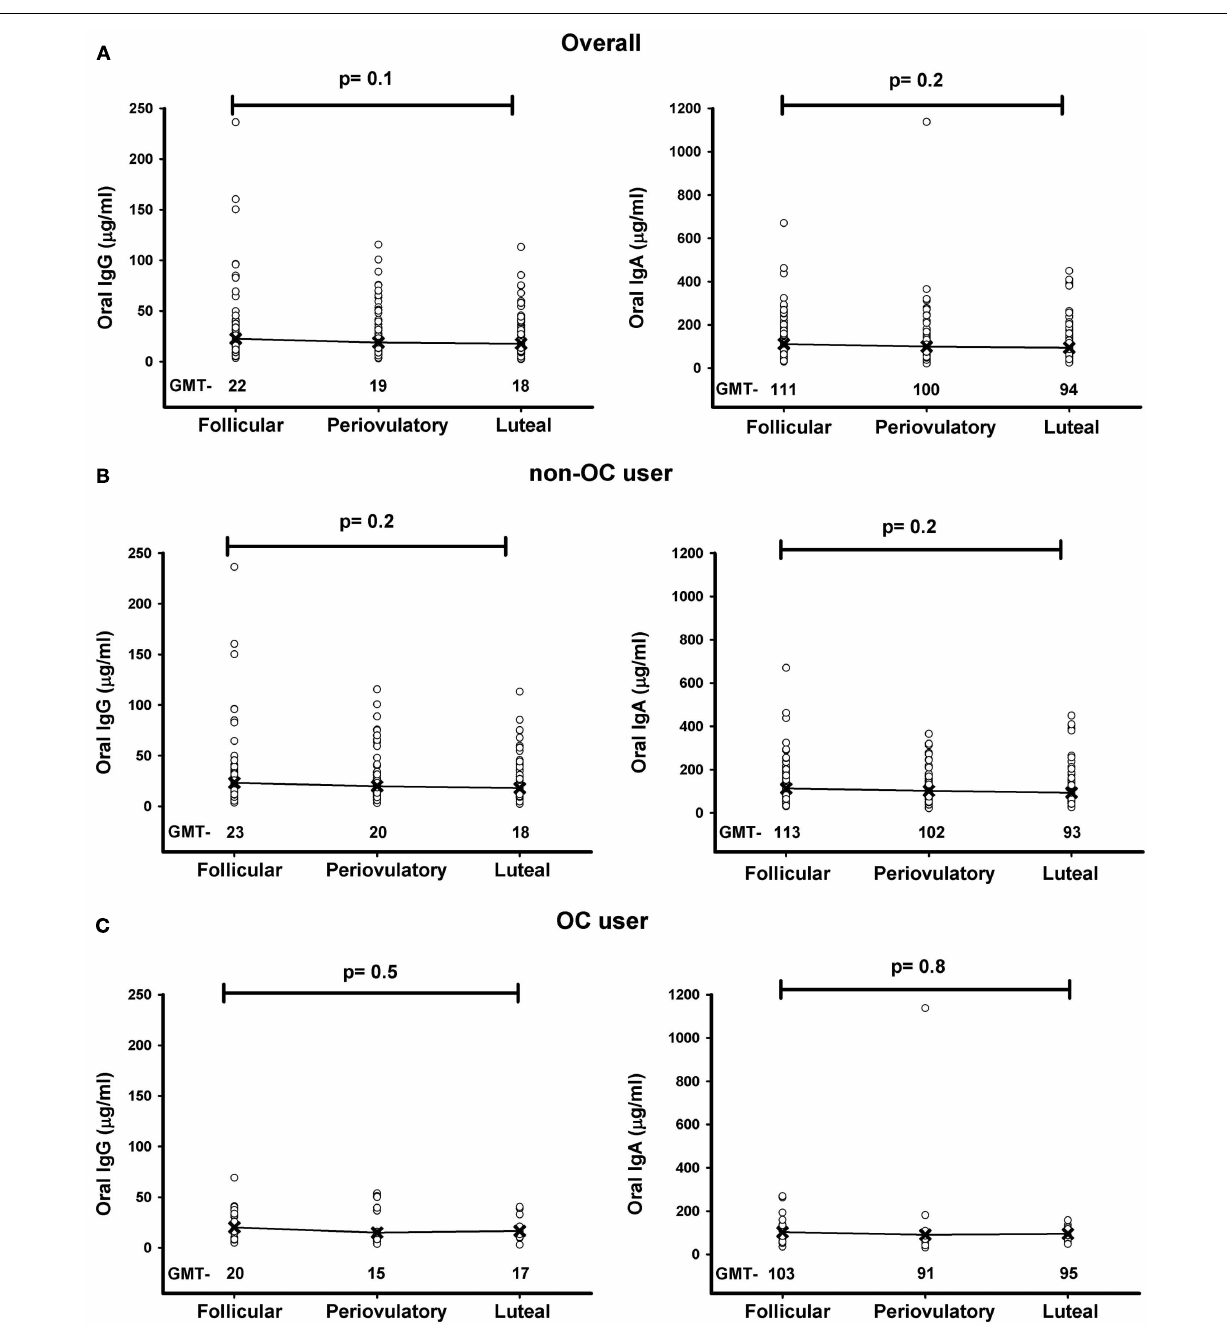
FIGURE 2 | Distribution of oral IgG and IgA levels during the three phases (follicular, periovulatory, and luteal) of the menstrual cycle overall (A) and stratified by oral contraceptive (OC) use (B,C). The levels of IgG